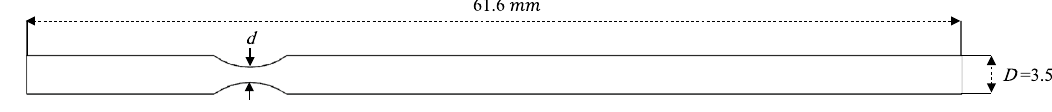
Fig. 1 Schematic of the computational domain (A straight cylindrical vessel with an idealized stenosis with Variable d/D )